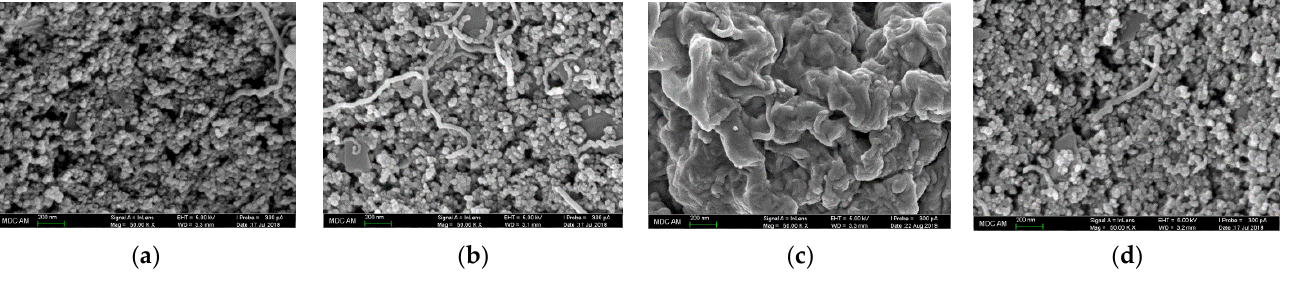
Figure 2. SEM images of the electrode surface: ( a ) poly(gallic acid)/MWCNTs/GCE; ( b ) poly(ellagic acid)/MWCNTs/GCE; ( c ) polyaluminon/f-SWNTs/GCE; ( d )